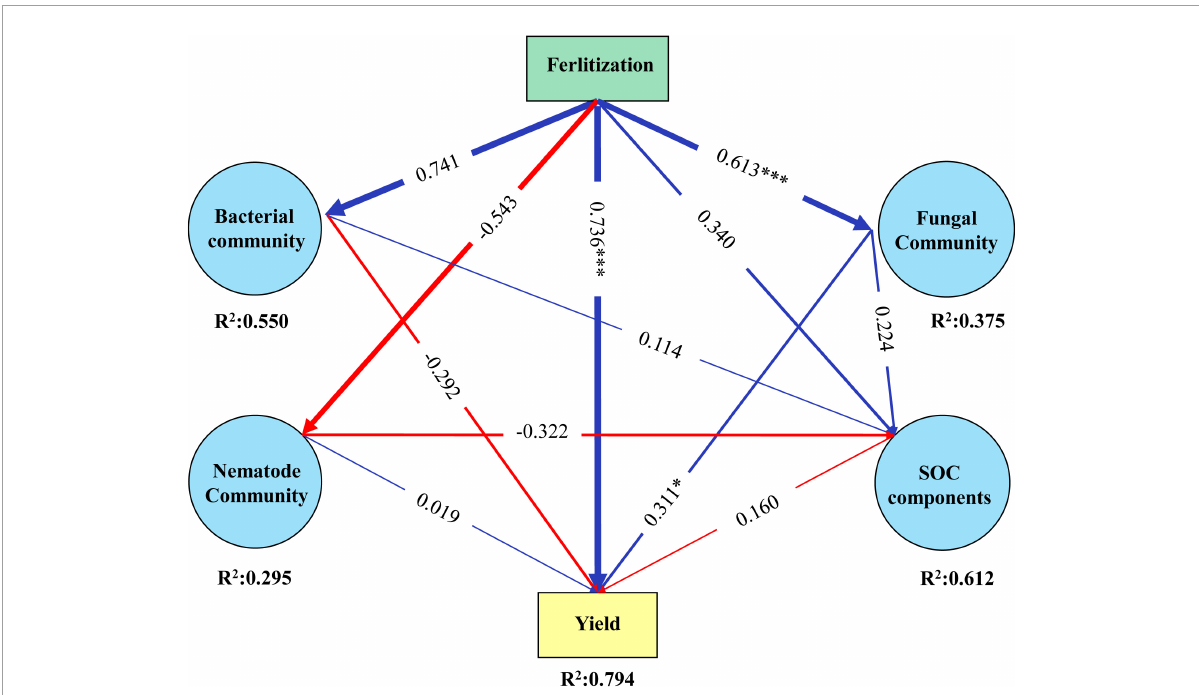
FIGURE4 Partial least squares path models (PLS-PM) displaying the direct and indirect effects of long-term fertilization, SOC components (SOC, POC, DOC, and MBC), microbial and nematode community compositions on the jackfruit yield (Goodness-of-Fit = 0.484). Microbial and nematode compositions are used as latent variables, reflecting the relative abundance of each phylum and trophic group, respectively. Coefficient of determination ( R 2 ) values denote the proportion of variance explaining for each variable. Arrow thickness is scaled proportionally to the standardized path coefficients (numbers on arrows). Solid blue and red arrows indicate positive and negative relationships,